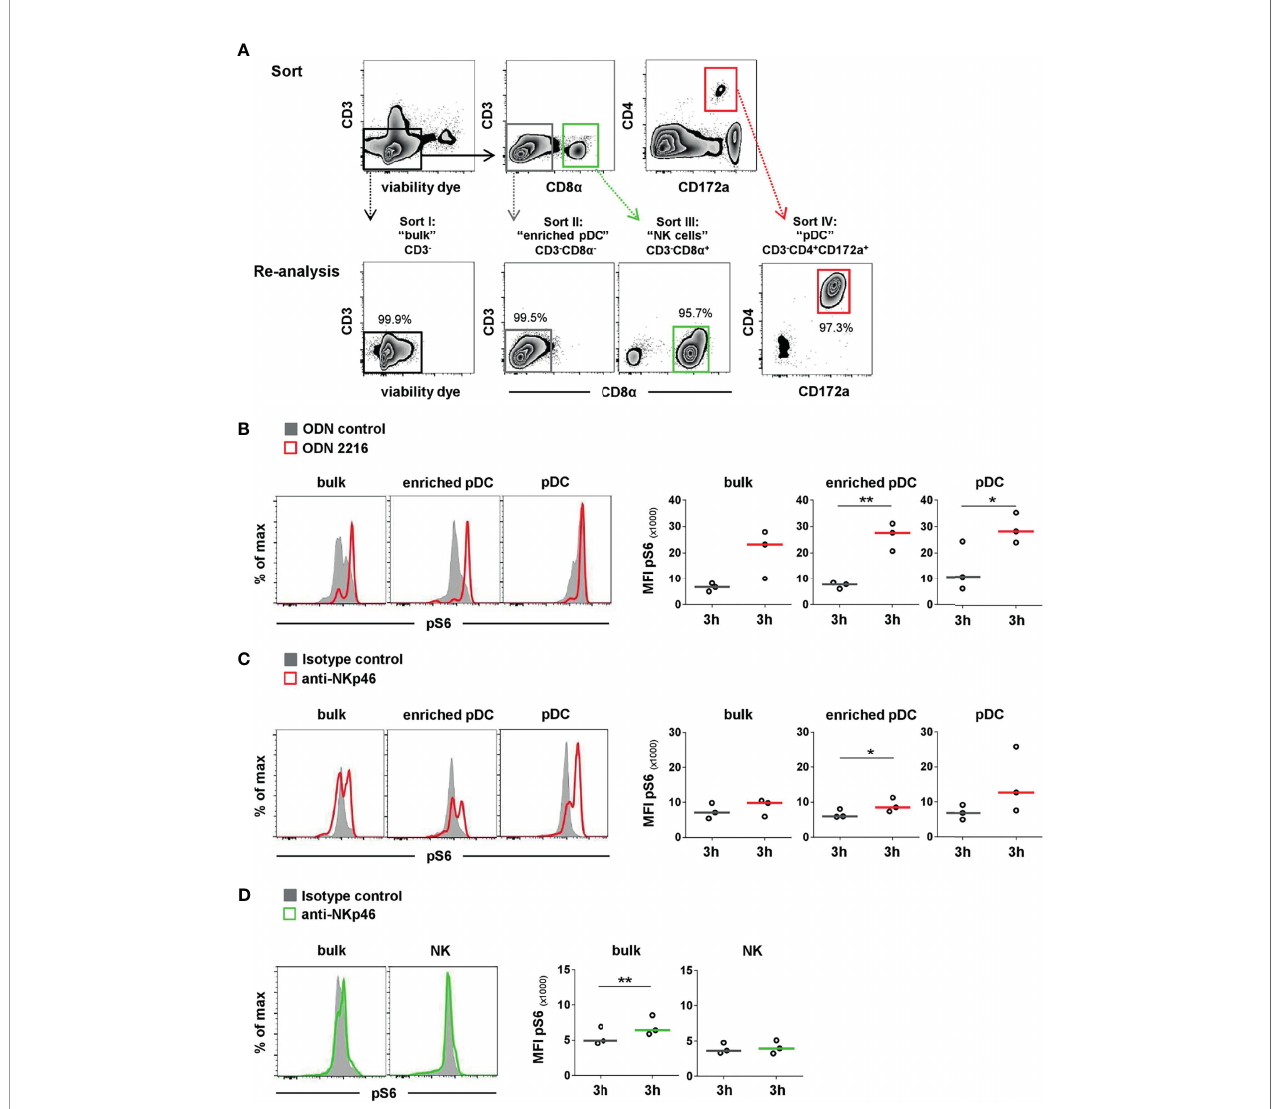
FIGURE 5 | Activation of sorted pDC and NK-cell populations by NKp46 receptor triggering. (A) PBMC were depleted of T cells by MACS (CD3 - , data not shown) and further sorted by FACS into four populations. I: non-T cells (CD3 - ), representing “ bulk ” culture; II: CD3 - CD8 a - , representing “ enriched pDC ” ; III: CD3 - CD8 a + “ NK cells ” ; IV: CD3 - CD4 + CD172a + “ pDC ” . Obtained purity of sorted populations was analyzed, and a representative reanalysis is shown in the zebra plots at the bottom. Induction of pS6 within gated pDC of NK populations (bulk, enriched) or pure pDC and NK-cell populations was assessed after 3 h in vitro stimulation. (B) Cells were incubated with the TLR9 agonist ODN 2216 (red) or with non-stimulatory oligonucleotides (ODN control, gray). Activation by NKp46 triggering of (C) pDCs (red) and (D) NK cells (green) was assessed after incubation with plate-bound NKp46 mAbs. Plates coated with isotype-matched irrelevant antibodies served as controls (gray). Cells for NK-cell analyses were additionally pre-activated with rpIL-2 and rpIL-15 for 24 h. (B – D) Histograms show results of pS6 induction for one representative animal. MFIs of pS6 within pDCs and NK cells are shown for analyses of three individual animals in the graphs on the right. Median values are represented by colored bars. Signi fi cant differences between stimulated and non-stimulated cells are indicated (* p ≤ 0.05 , ** p ≤ 0.01 ). (B, C) In “ bulk ” and “ enriched pDC ” cultures, pDC were gated according to a CD4 + CD172a + phenotype. (D) In “ bulk ” cultures, NK cells were gated according to a CD8 a +